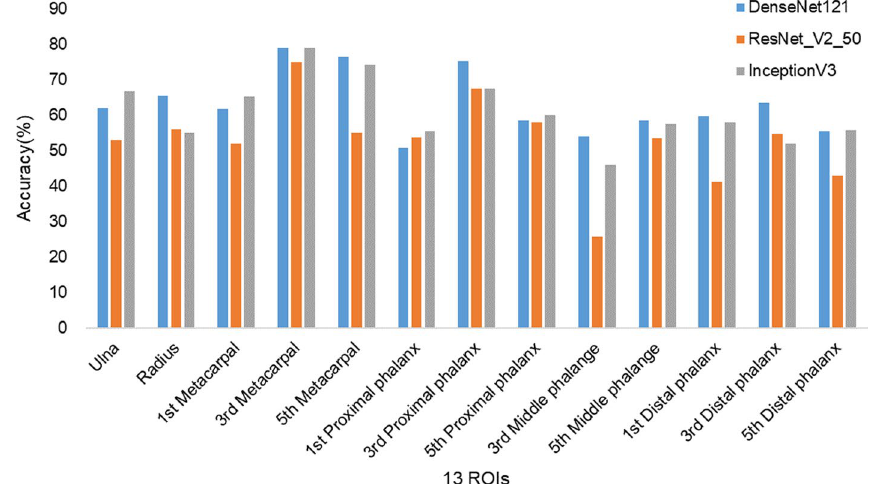
Fig. 14 Test result of the BAA of all ROIs